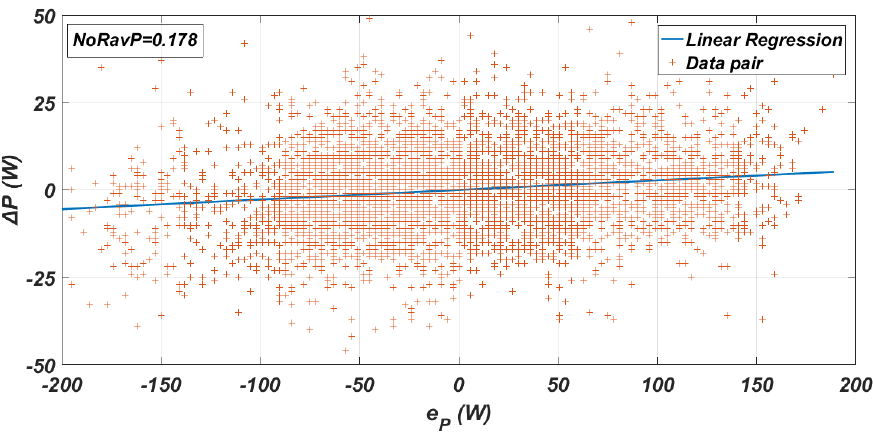
Figure 5. Plot and linear regression of [ e P ( t ), ΔP ( t )] pairs used for the calculation of NoRavP for droop control.